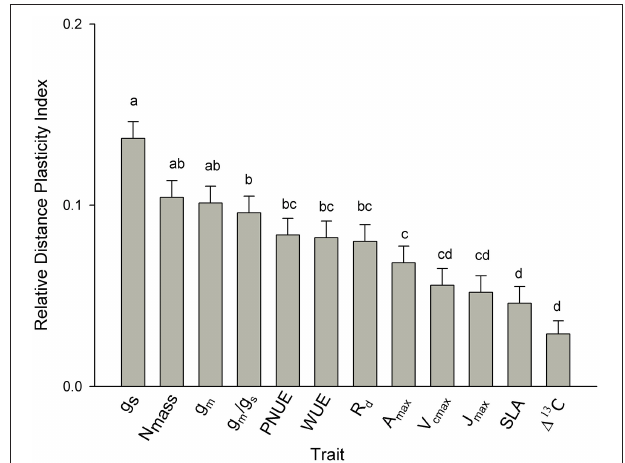
FIGURE 5 | Comparison of phenotypic plasticity among traits across all seed sources as assessed by relative distance plasticity index (RDPI). Means having the same letters are not significantly different at α = 0.05 (Tukey post hoc ). Values are the means ± SD. (see Table 2 for